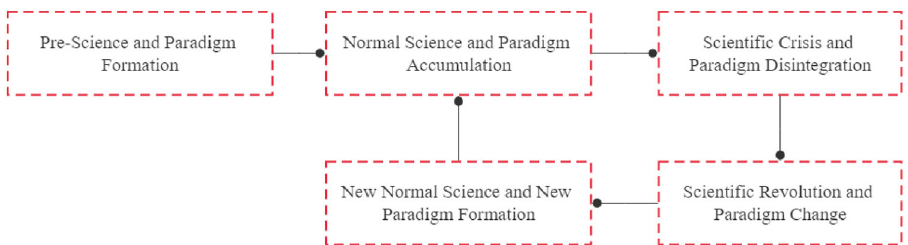
Fig. 3 Annual publication volume of HBIM-related literature. Annual publication volume of HBIM-related literature analyzed by CiteSpace bibliometric analysis software.